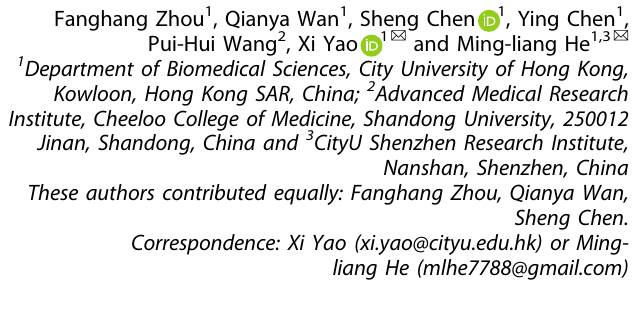
Fig. 1 a RD cells were ectopically expressed NSP1. After 48 h, hnRNPA2/B1 subcellular location is observed under a fl uorescence microscope. hnRNPA2/B1 is indicated as Red. Blue is DAPI. b RD cells were ectopically expressed NSP1 at 48 h. After 48 h, hnRNP A1 subcellular location is observed under a fl uorescence microscope. hnRNPA1 is indicated as red. Blue is DAPI. c , d HEK293T cells were transfected with NSP1 for 36 or 48 h. Then mRNA level of IFNß and its downstream ISGs was detected by RT-qPCR, unpaired t test, P < 0.01. e 293T cells were fi rstly silenced hnRNP A2/B1 by speci fi ed siRNA for 24 h, following the ectopic expression of viral protein NSP1 for 48 h. The mRNA levels of IFNß, TNF alpha, and IL-6 in 293T cells were determined by qRT-PCR, unpaired t test, P < 0.05. f HEK293T cells were transfected with control/NSP1 plasmids for 48 h, then treated with/without IFN α (1000 U/ml) for 30 min. Cell lysates were collected for western blot assay. g HEK293T cells were transfected with speci fi c siRNA for 24 h followed by 1000 U/ml of IFN α treatment for 30 min. Cell lysates were collected for western blot